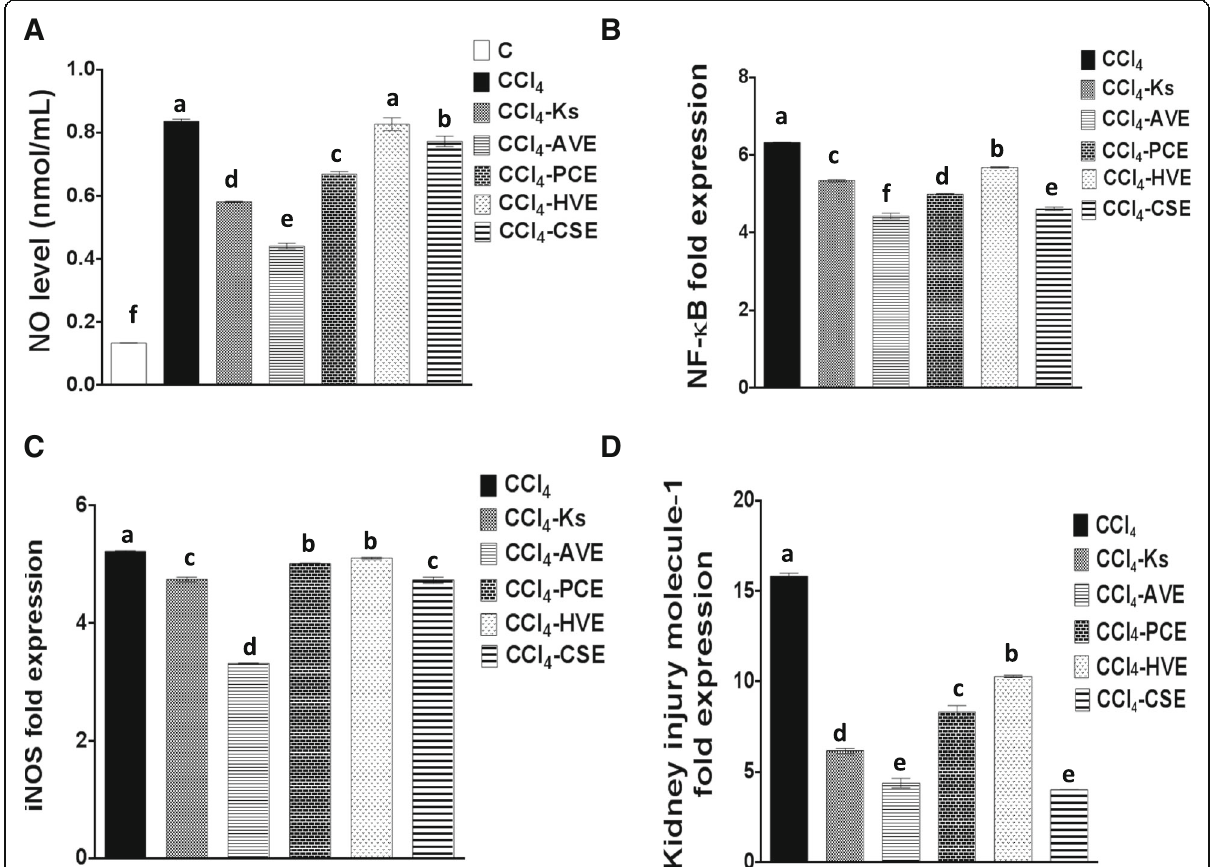
Fig. 4 Effect of the studied extracts on the carbon tetrachloride (CCl 4 )-induced inflammation and injury in Vero Cells in comparison with the Ketosteril (Ks). ( a ) Nitric oxide (NO) level ( b ) Nuclear factor (NF) к B gene expression ( c ) Inducible nitric oxide synthase (iNOS) gene expression ( d ) Kidney injury molecule-1 gene expression. C ; the untreated control cells, AVE , Ammi visnaga extract; PCE , Petroselinum crispum extract; HVE , Hordeum vulgare extract; CSE , Cymbopogon schoenanthus extract. Results are presented as mean ± SE ( n = 3). Different letters for the same parameter are significantly different at p <